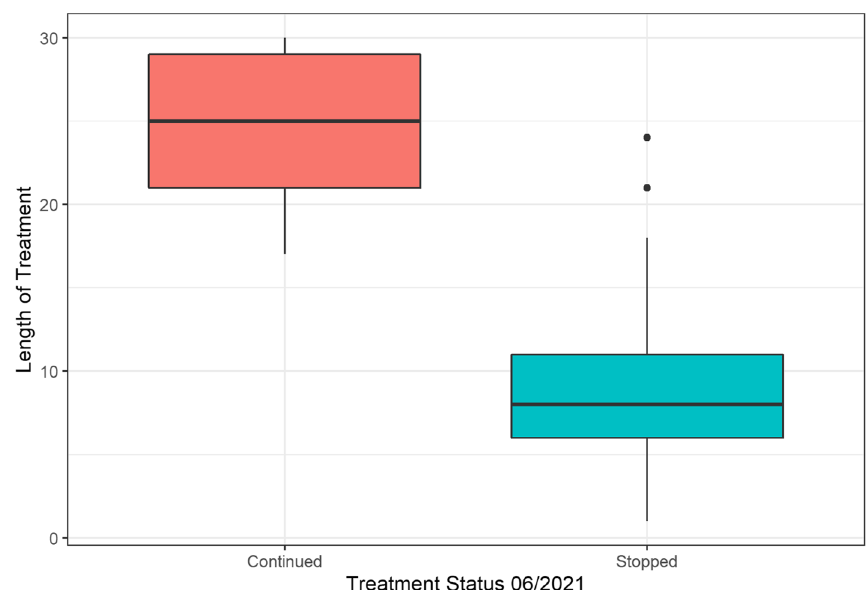
Fig. 7 Boxplot comparing length of treatment between patients who stopped treatment vs patients who continued